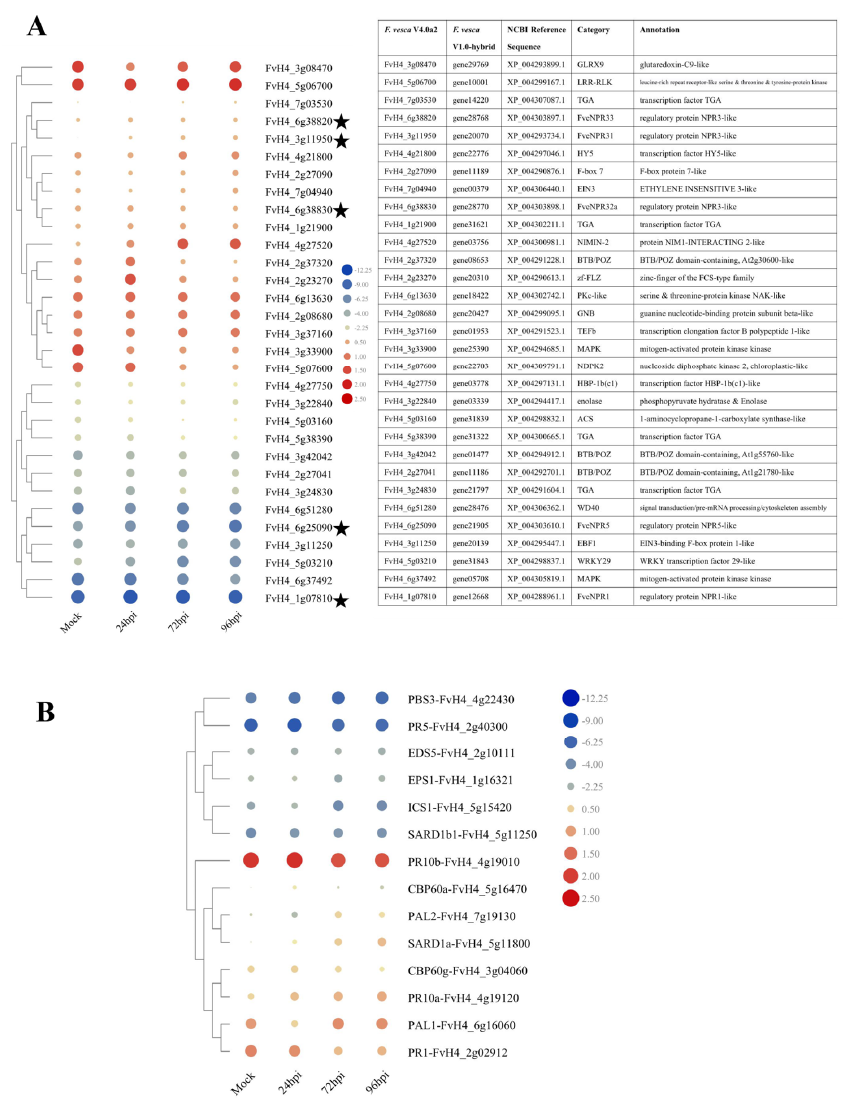
Figure 9. RNA-seq data showing the differential expression of genes coding proteins potentially directly or indirectly interacting with NPR1-like proteins ( A ) and the other known members in SA signaling ( B ) in strawberry during the C. fructicola invasion. The heatmap was generated using RPKM (reads per kilobase per million mapped reads) values normalized via Log2-transformation for each transcript in a moderate susceptible strawberry cv. ‘Jiuxiang’ mock-treated or infected by C. fructicola at 24, 72, or 96 hpi. The black star symbols indicate NPR family members. Strawberry materials and C. fructicola inoculation conditions for RNA-seq data generation have been reported previously [35].